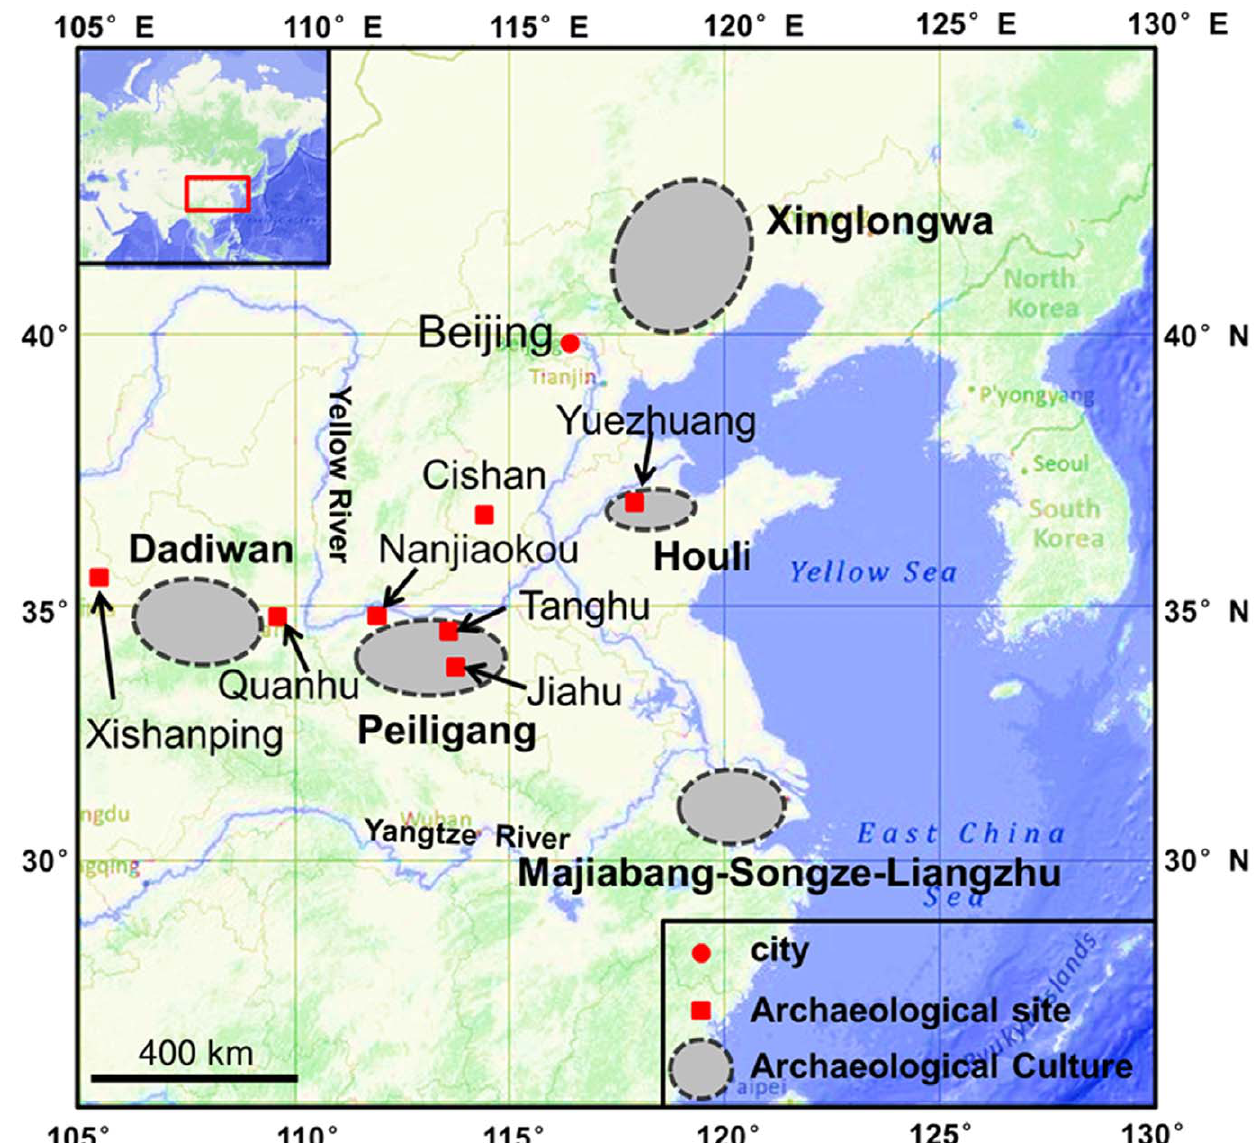
Figure 1. Archaeological sites and related cultures mentioned in the article. The map cited from http://maps.ngdc.noaa.gov/viewers/ bathymetry/. (Figure 2). A prehistoric culture, Peiligang Culture, developed there and extended into the Shang and Zhou dynasties [25,26].